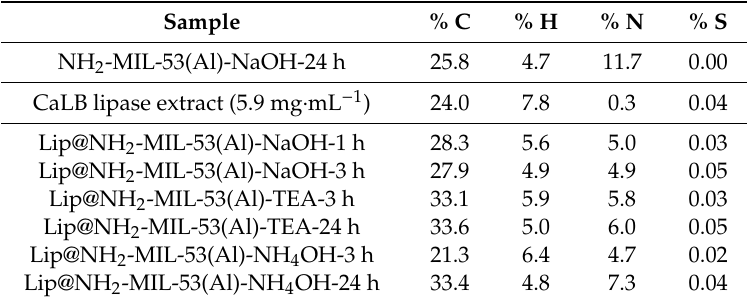
Table 2. Elemental analysis (in wt%) of the enzyme-free MOF material (NH 2 -MIL-53(Al)-NaOH-24